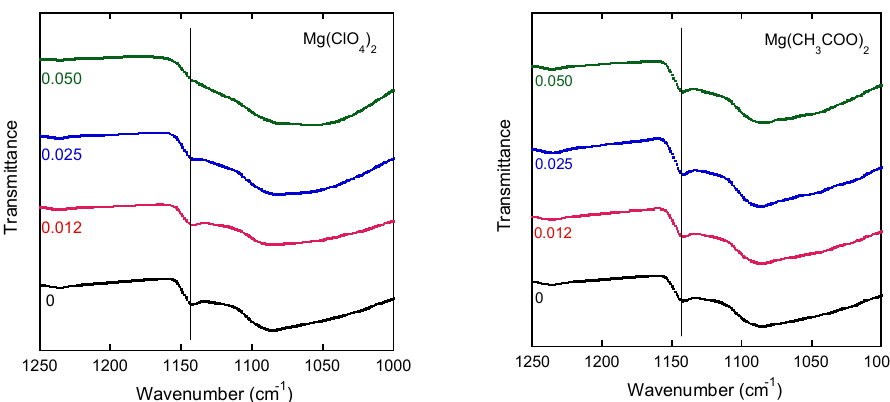
Figure 8. FT-IR spectra of the films containing Mg(ClO 4 ) 2 (left) and Mg(CH 3 COO) 2 (right) in the wavenumber range 1000–1250 cm − 1 . The numerals in the figure represent the molar ratios of the salts.